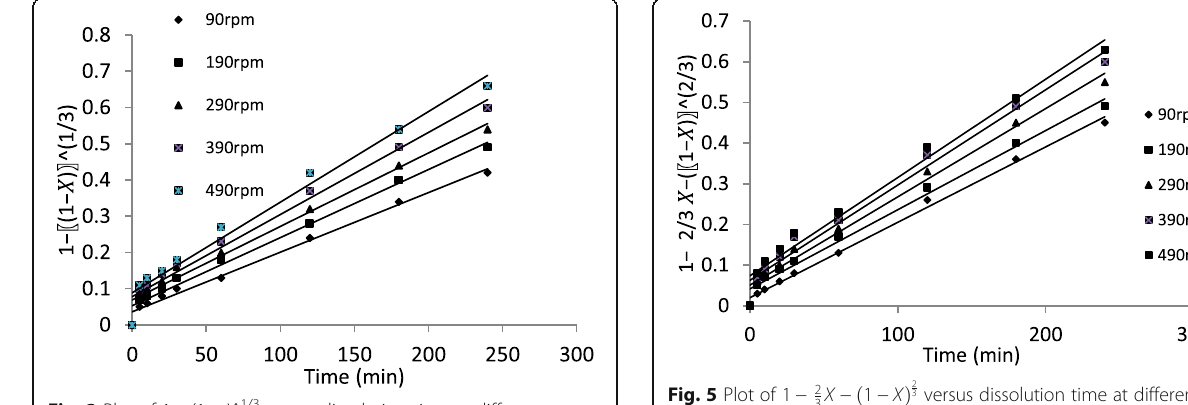
Fig. 3 Plot of 1 − (1 − X ) 1/3 versus dissolution time at different agitation rates